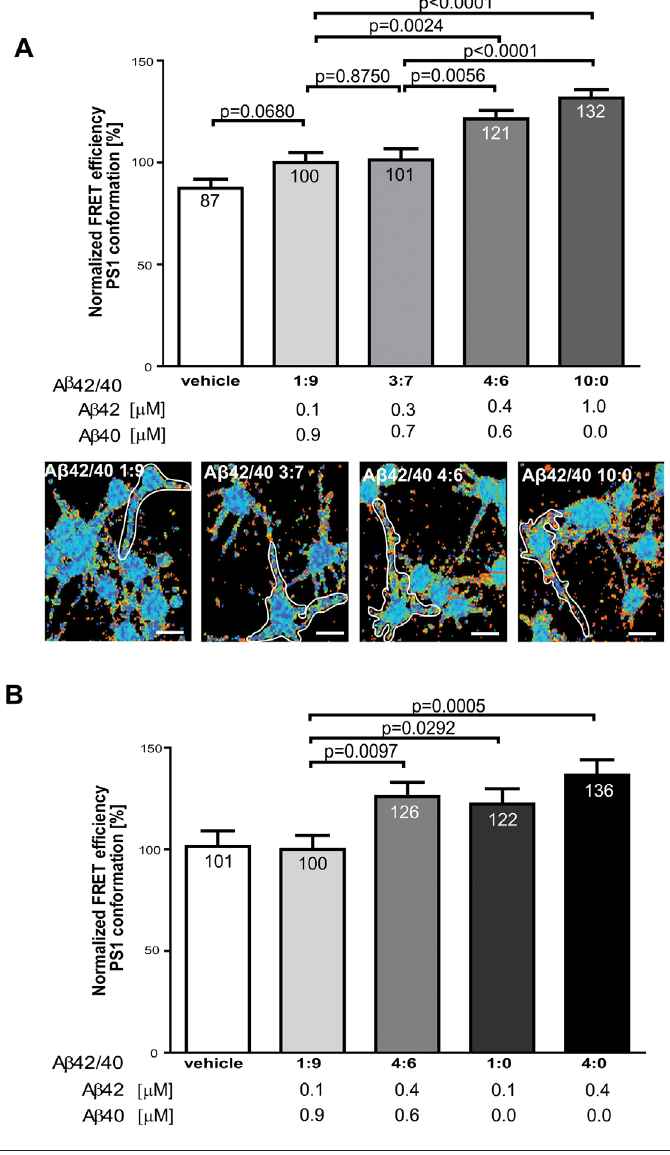
Figure 2. Effect of A β 42/40 ratio on PS1 conformation. (A) FLIM analysis of the PS1